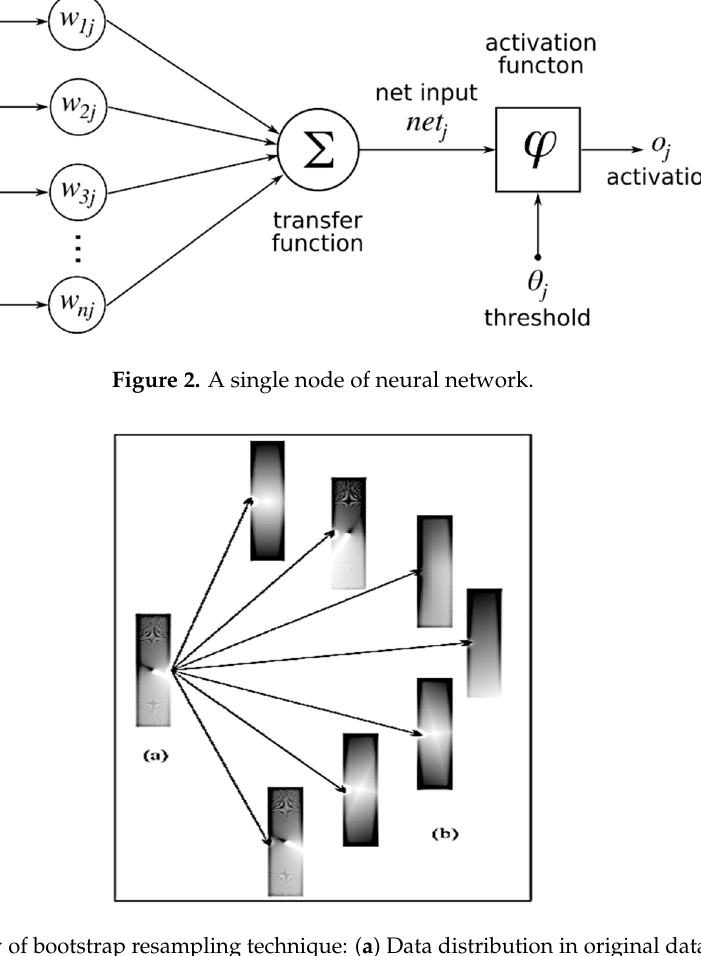
Figure 3. Analogy of bootstrap resampling technique: ( a ) Data distribution in original dataset; ( b ) data distribution in new datasets after resampling [29].